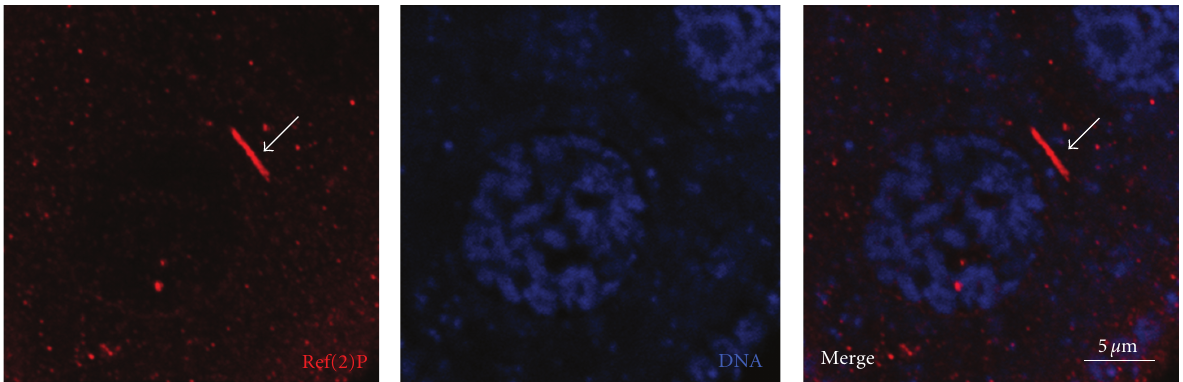
Figure 3: Ref(2)P localization in Drosophila egg chamber. Confocal micrograph of a middle section of a stage 8 egg chamber of wild-type fly, illustrating a portion of a nurse cell. The tissue is stained for Ref(2)P (red) and DNA (blue). Note the rod-like structure stained for Ref(2)P